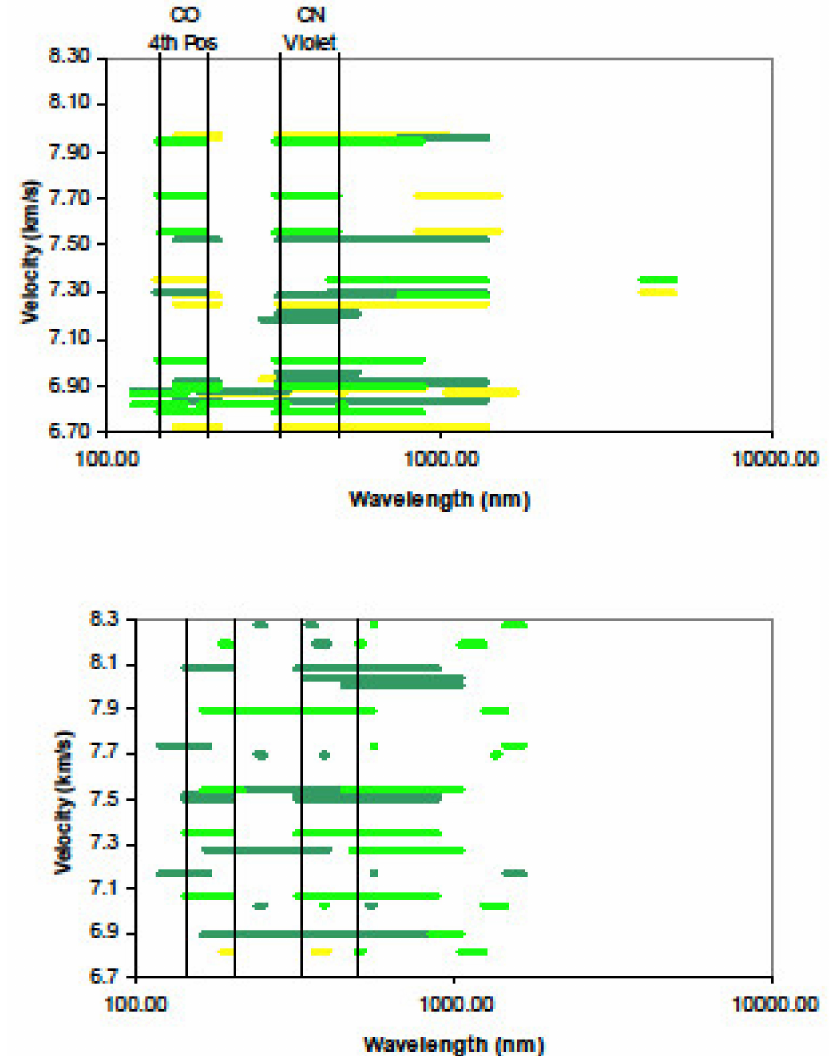
Figure 24. Spectral ranges covered during EAST tests (bottom 1 Torr, top 0.1 Torr (from [25]).